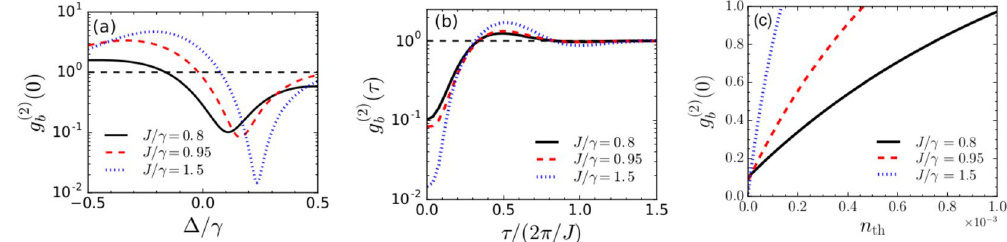
Figure 3. ( a ) Plot showing the variation of g (0) Second-order correlation function with finite time-delay, τ g ( ) Other parameters are: Ω 1 = 0.1 γ , U = U opt and Δ = Δ opt . The dashed black lines correspond to = g (0) 1